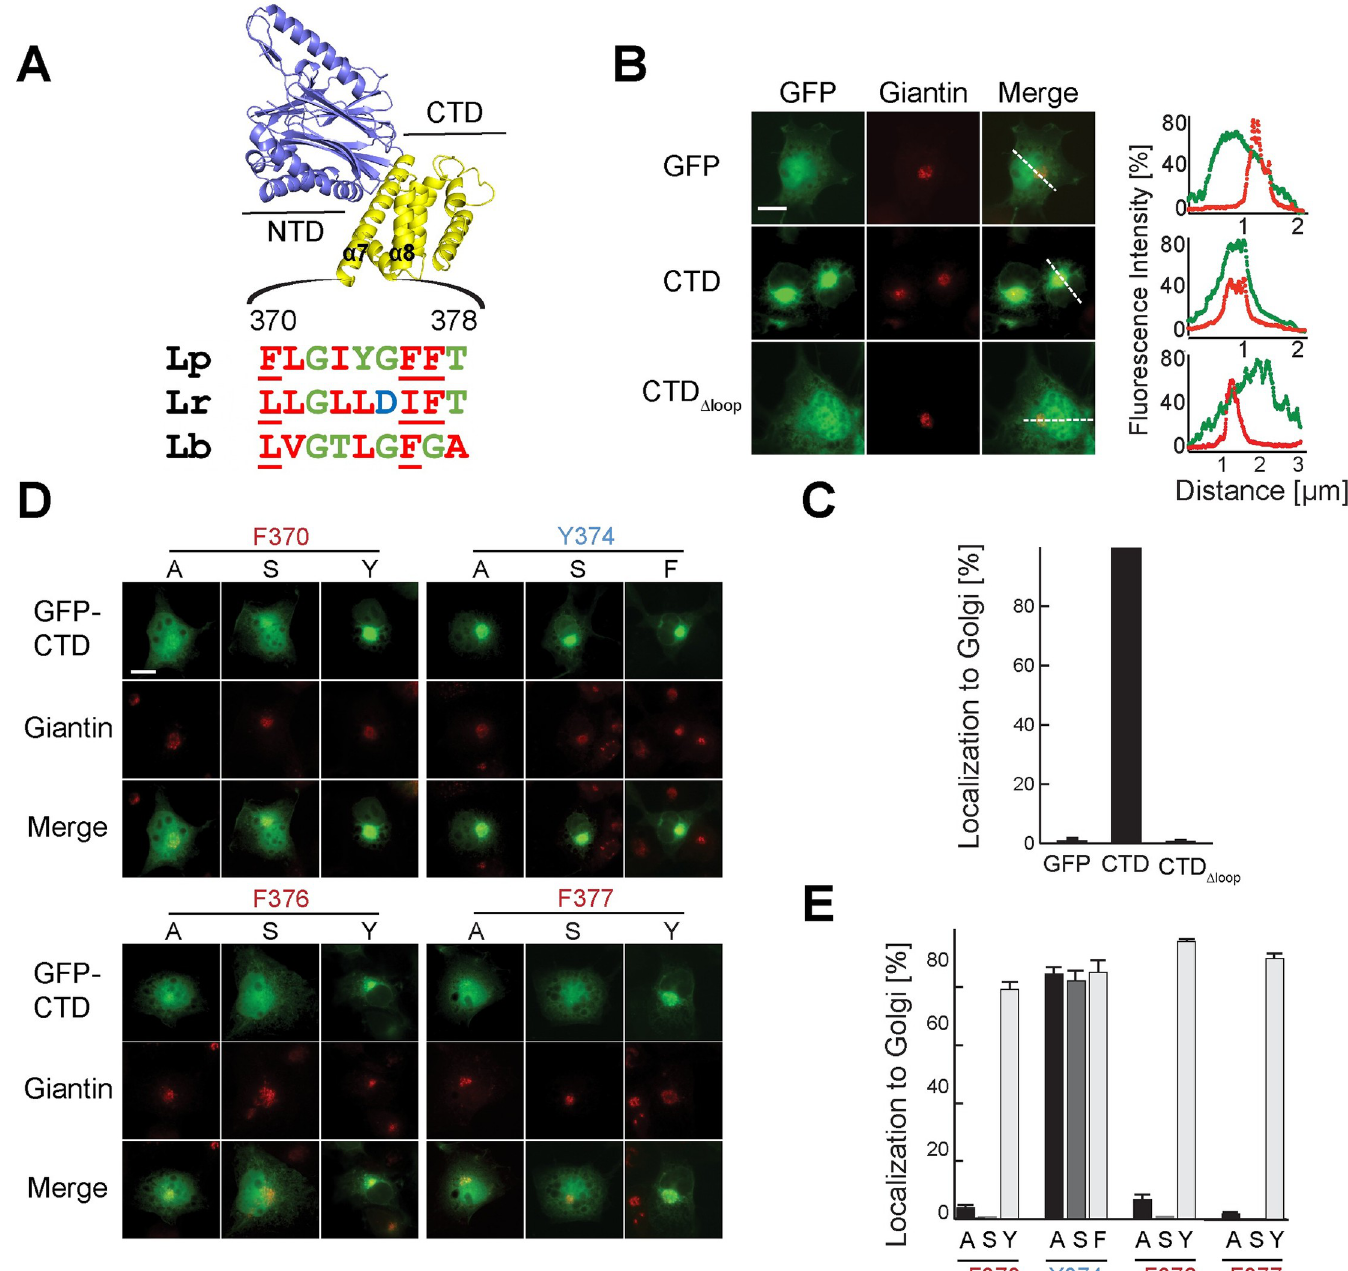
Fig 3. A hydrophobic loop within the CTD is required for SidD localization. (A) Schematic representation of the position and composition of the loop CTD and alignment with SidD homologs from L . rowbothamii (Lr) and L . belliardensis (Lb). Hydrophobic residues within the loop region are colored in red. NTD, N-terminal domain; CTD, C-terminal domain. Numbers indicate amino acid positions. (B) Intracellular localization of CTD variants. Transiently transfected COS-1 cells producing either GFP (control) or GFP-CTD variants were fixed and stained using an antibody directed against the Golgi marker protein giantin ( middle ). Merged images show SidD proteins in green and giantin in red. Scale bar, 10 μ m. Line scans ( right ) indicate pixel intensity of the green (GFP) and red (giantin) fluorescent signals along the dashed lines (distance in μ m). (C) Quantification of (B) showing percentage of cells with SidD enrichment at the Golgi compartment. Numbers are results from at least 100 cells per sample and experiment. The graph represents the average of three biological replicates. (D) Effect of aromatic residue substitutions on intracellular localization of the CTD. Transiently transfected COS-1 cells producing either GFP (control, see panel B) or the indicated GFP-CTD mutants were chemically fixed, and stained for giantin to label the Golgi. The localization of CTD was evaluated by fluorescence microscopy. Amino acid substitutions at position F370, Y374, F376, and F377 were as follows: alanine (A), serine (S), tyrosine (Y), phenylalanine (F). Scale bar, 10 μ m. (E) Quantification of (D) scoring cells with colocalization of GFP-CTD and giantin. The graph represents the average of at least 100 transfected cells from three biological replicates.